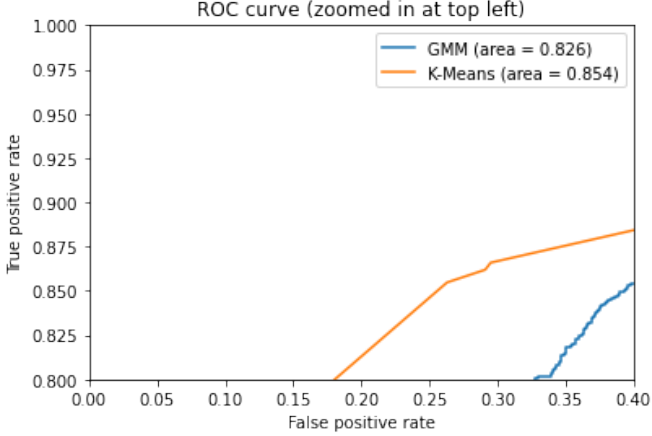
Figure 25. ROC curve for GMM and K-Means, zoomed in at top